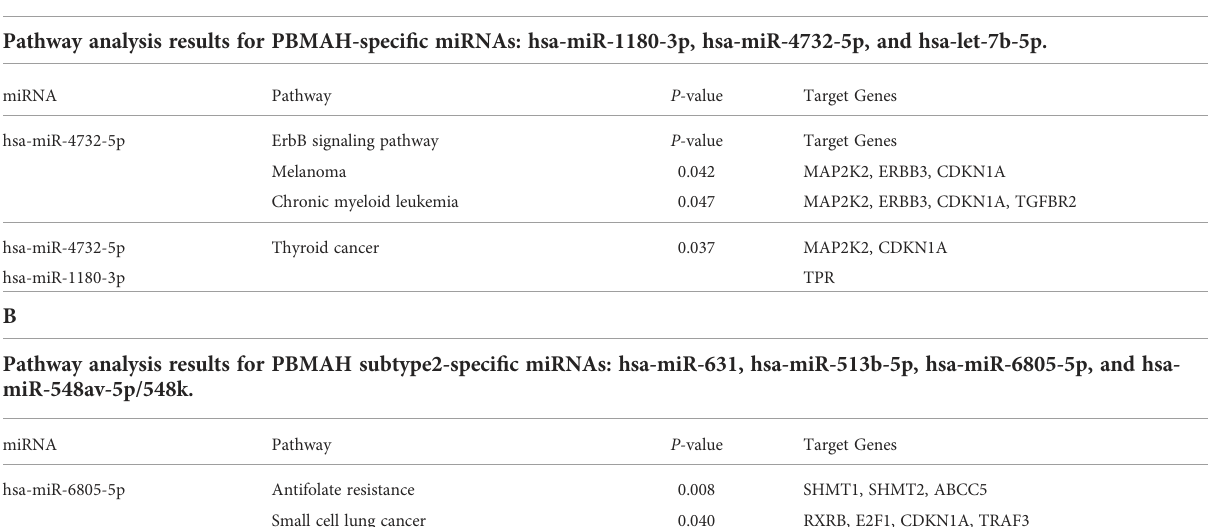
TABLE 4 Pathway analysis of discriminative miRNAs for PBMAH and PBMAH subtype 2.